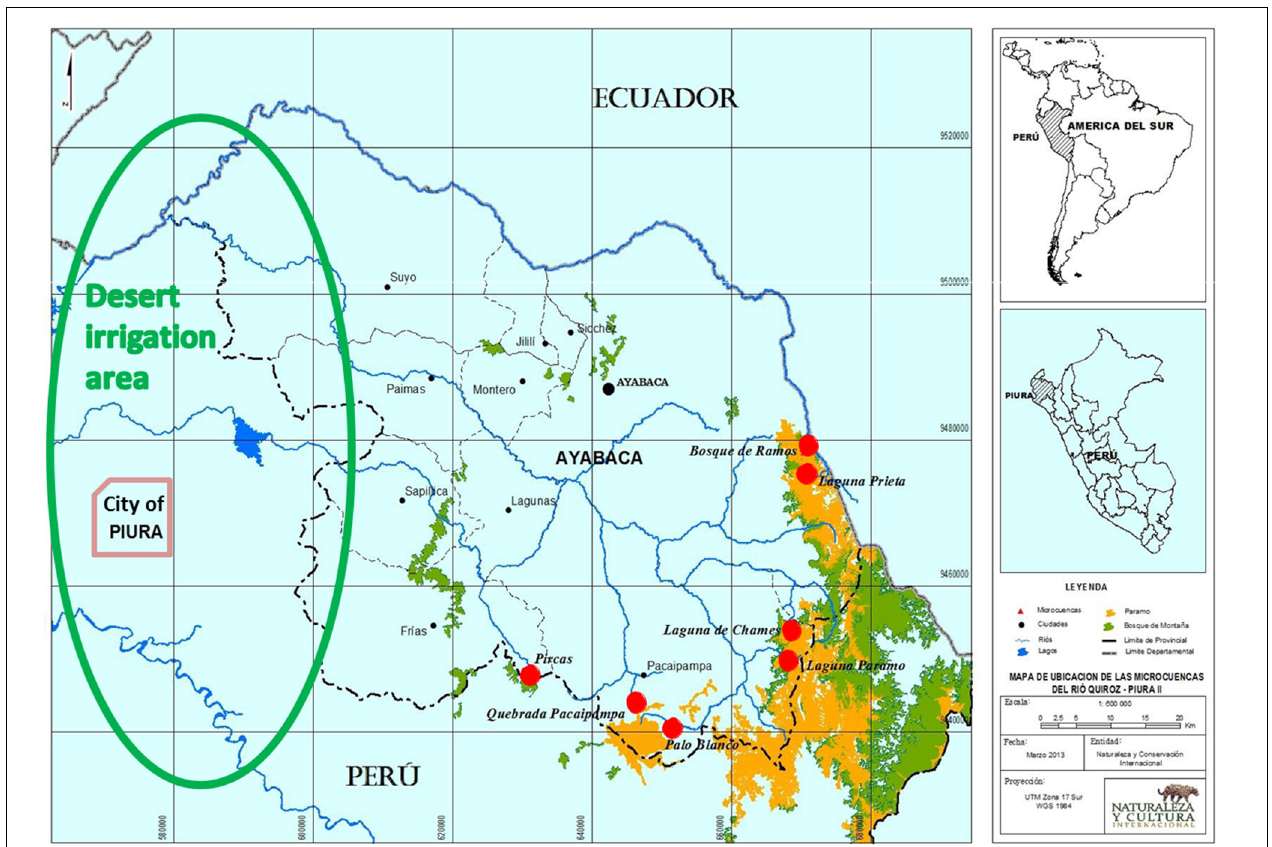
FIGURE 1 | Regional map of the Piura region showing the location of the iMHEA citizen science monitoring in the wet uplands (red dots).